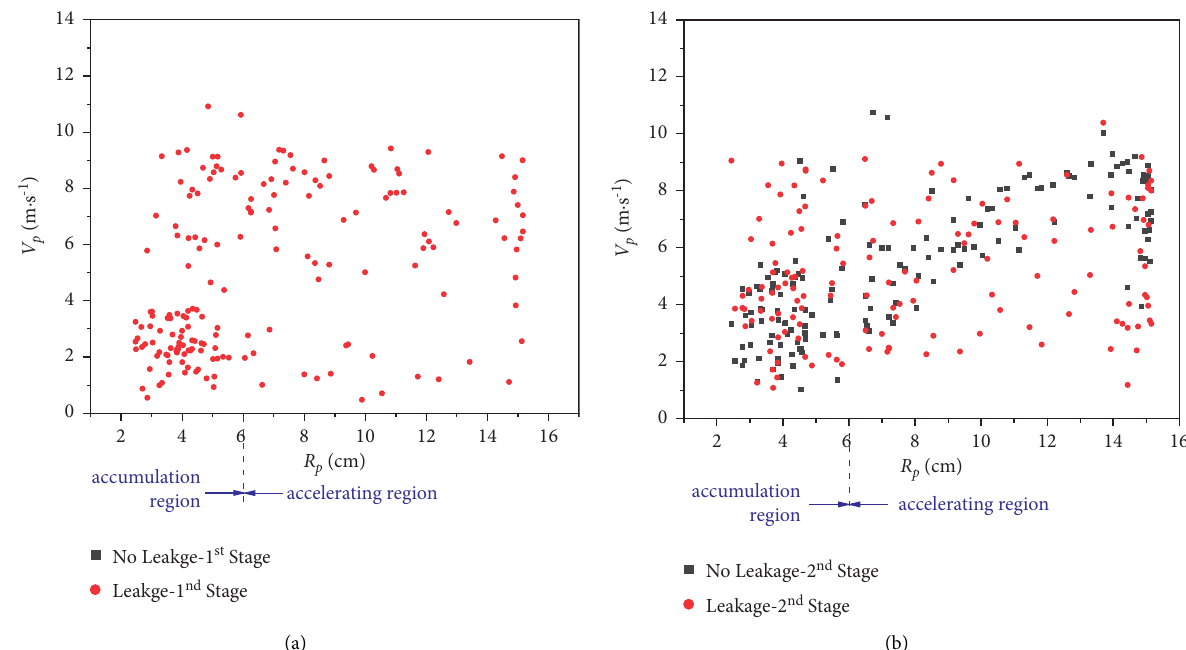
Figure 13: Particle velocity versus particle radial position in the impeller at 1.2s at Q � Q second